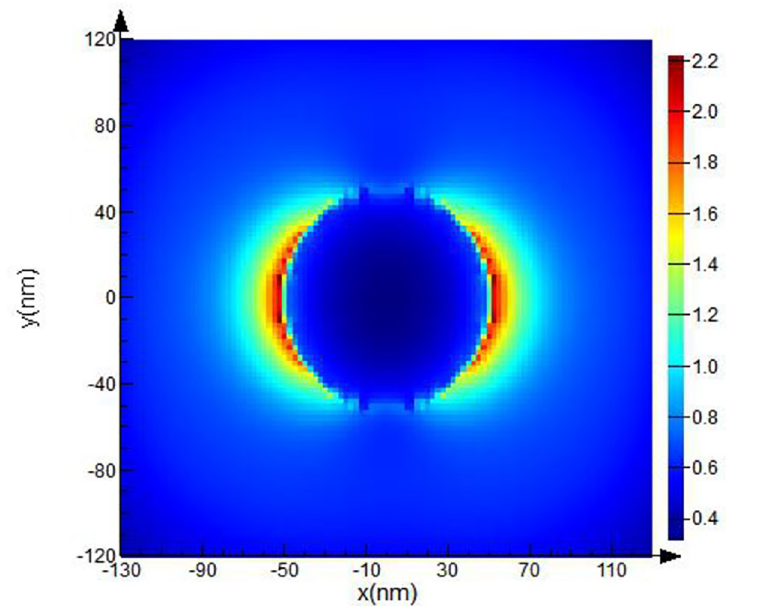
Fig 3. FDTD model of Pt NPs with 50 nm radii for λ = 251 nm excitation wavelength.